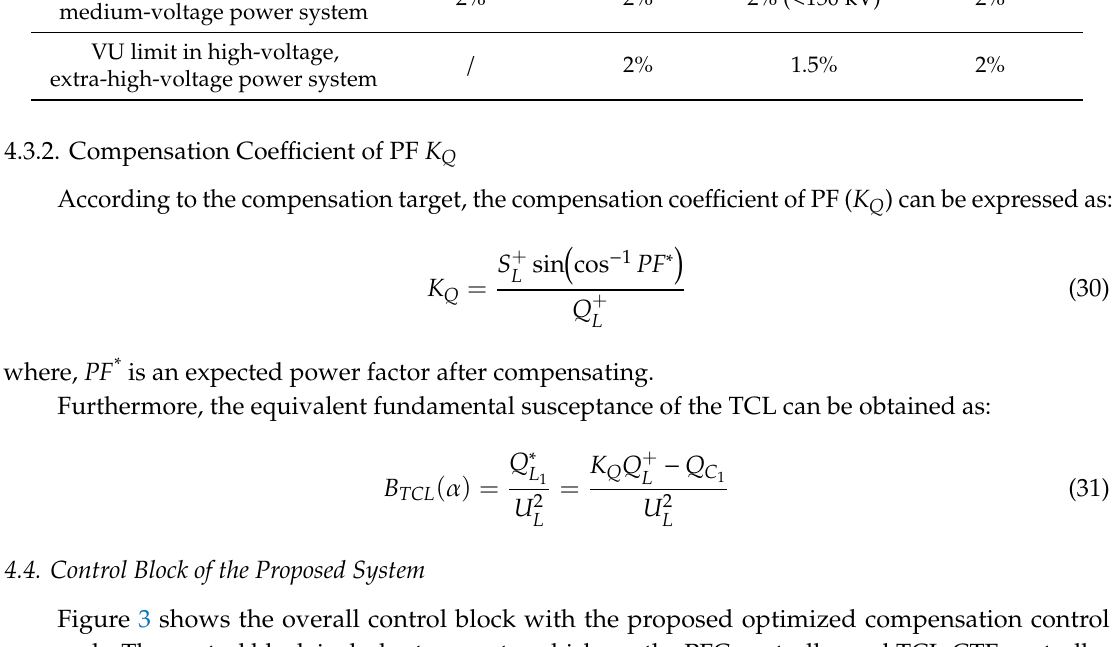
GB / T EDF Emeraude Grid Code EN 50160 Contract A.2 EU